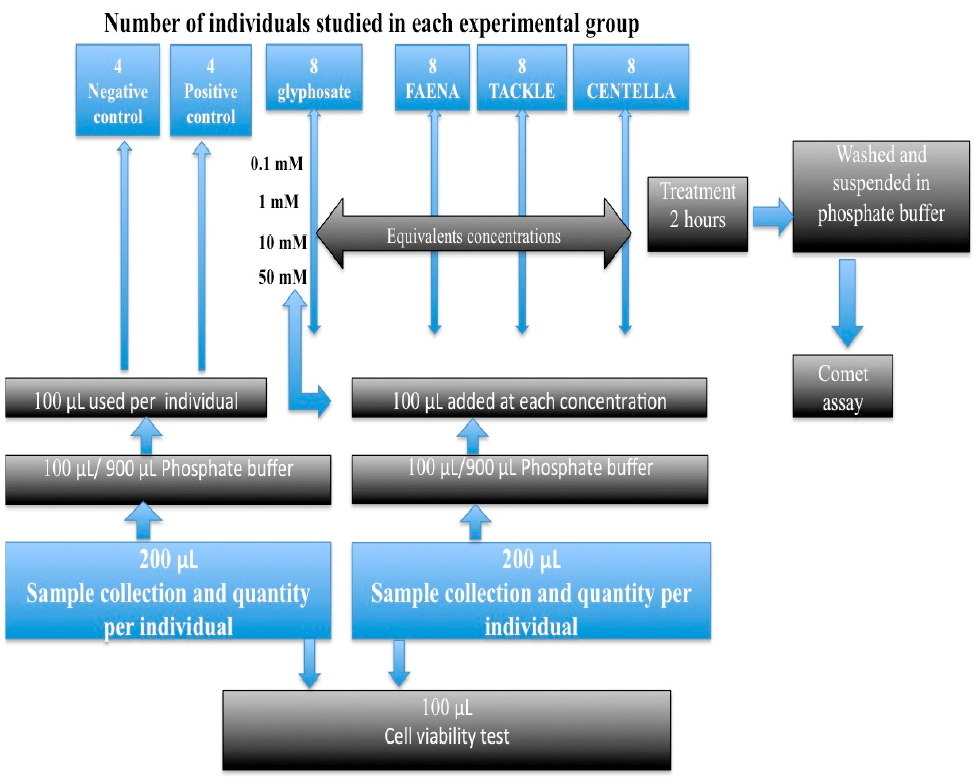
Figure 4. Diagram of the research process beginning with the sample collection.